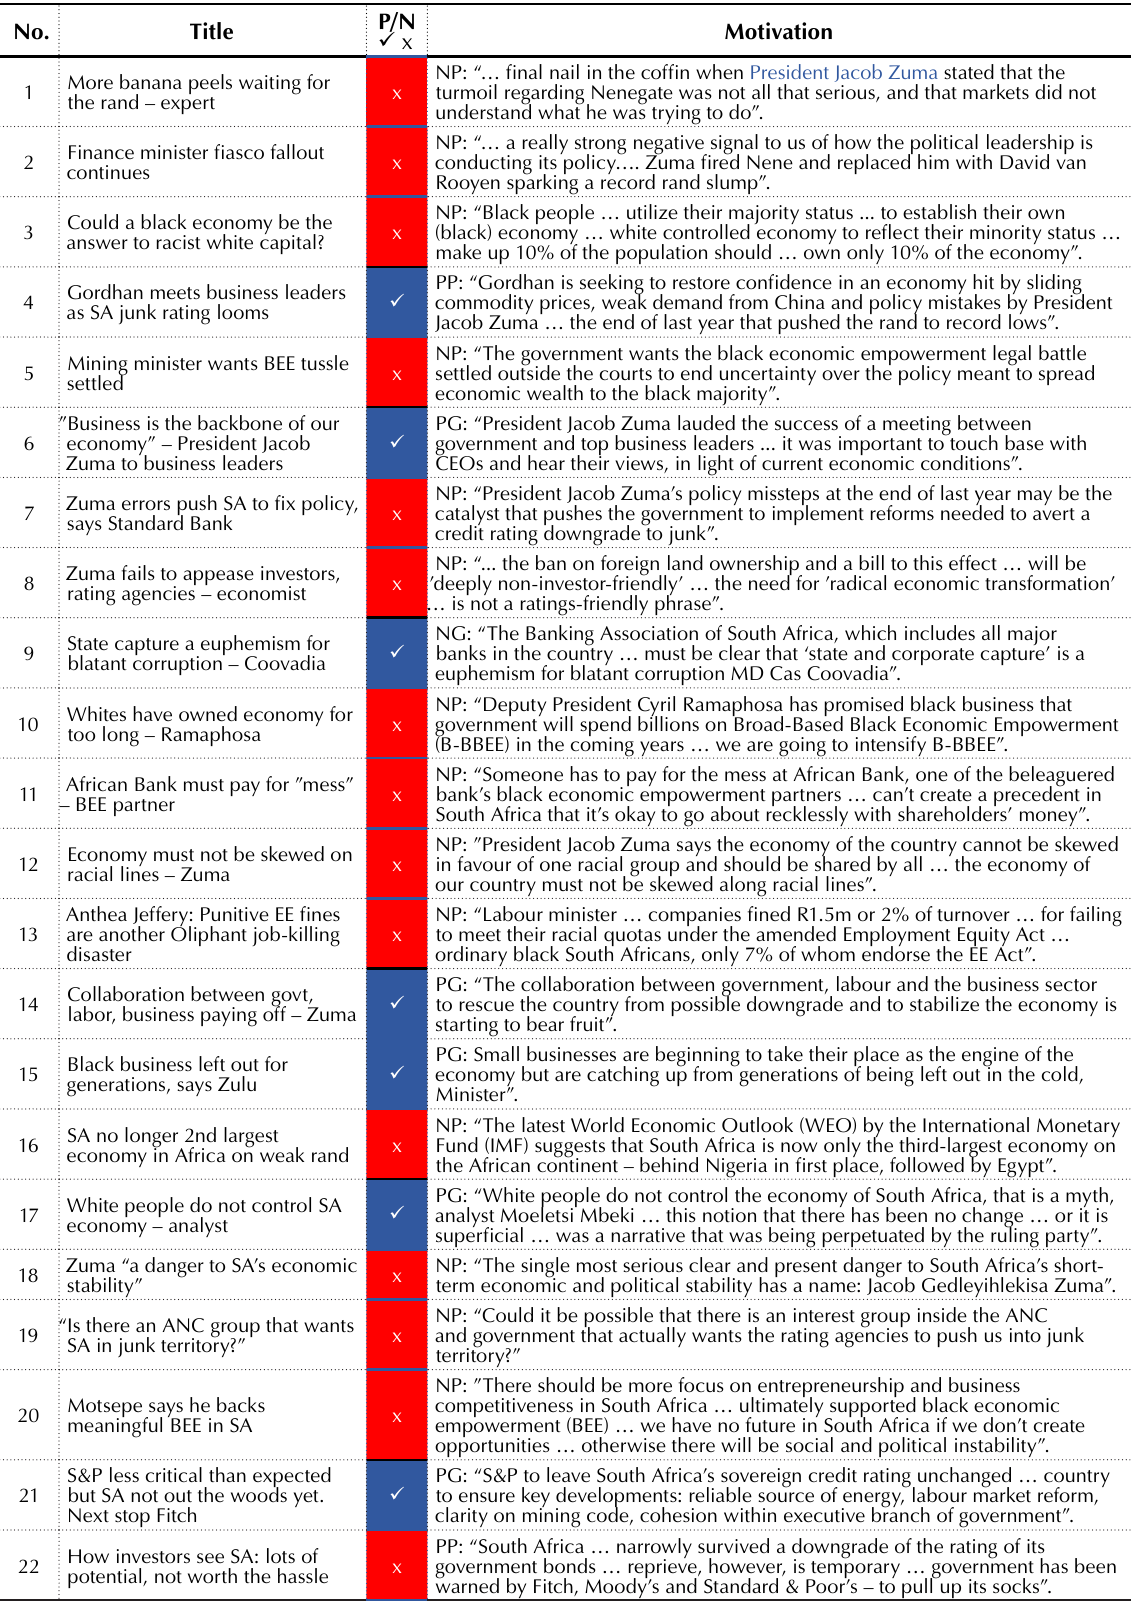
Table 2A. Economic macro-environment (January-June